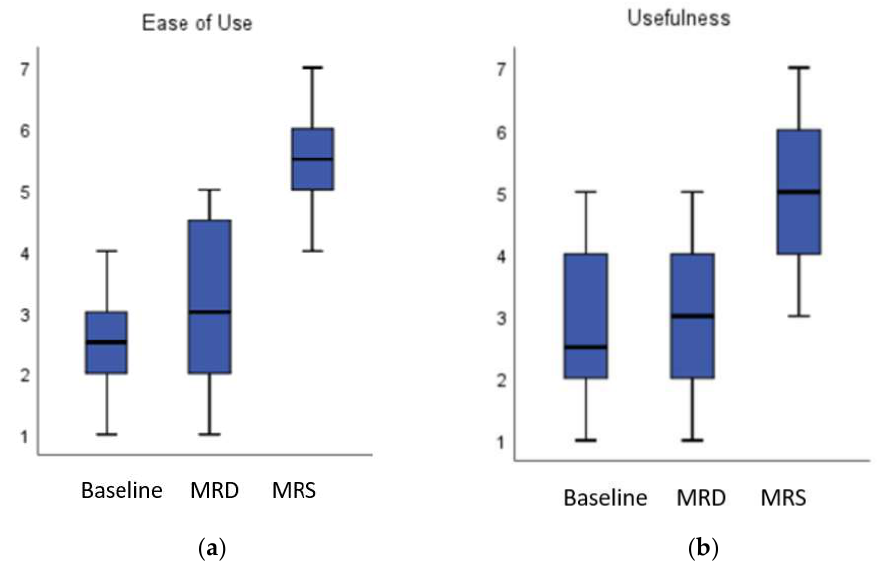
Figure 7. Boxplots of subjective measures about ease-of-use and usefulness for each HRI scheme across tasks. ( a ) The ease-of-use factor of user acceptance and perception; ( b ) the usefulness factor of user acceptance and perception. MRD and MRS denote MR SpaceMouse and MR subspace, re- spectively.